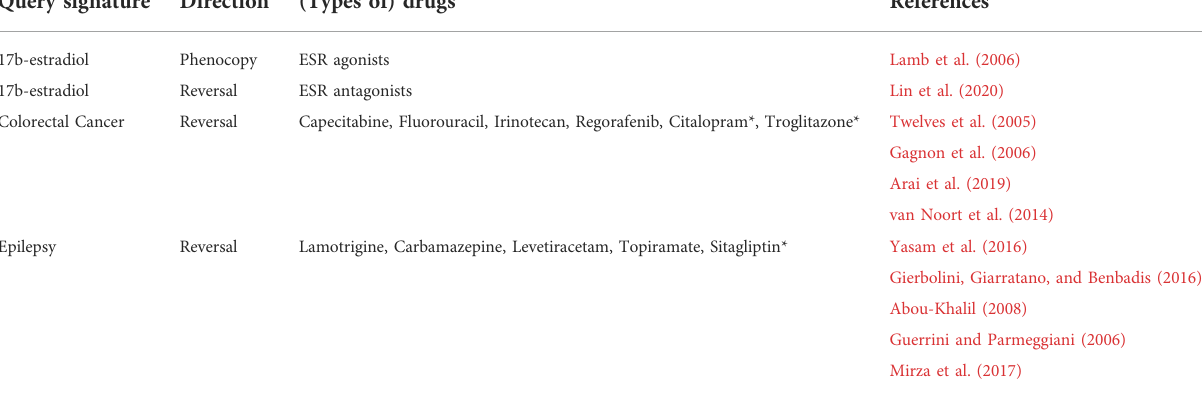
TABLE3 Listof drugsthataremarkedasphenocopyorreversalofthequerysignatures used inthis study,inordertoinvestigatetheaccuracy ofeach method.